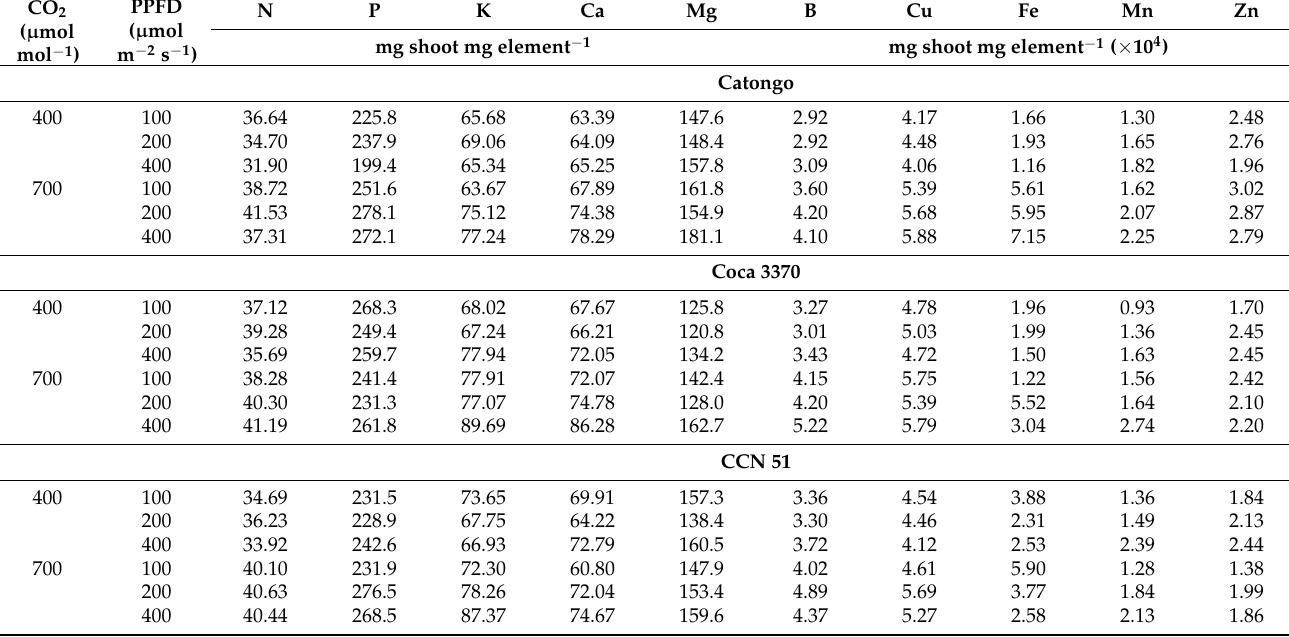
Table 7. The effect of [CO 2 ] and photosynthetic photon flux density (PPFD) on macro–micro nutrient use efficiency (NUE) of seven cacao